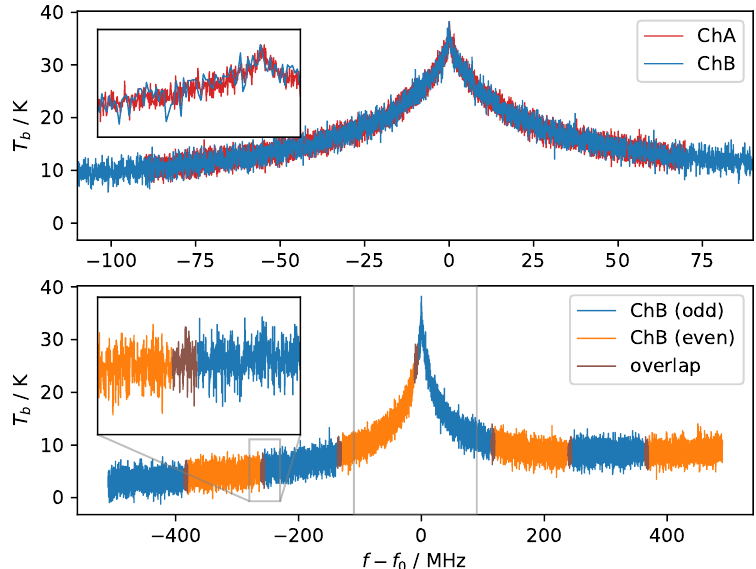
Figure 2. Spectra from the WIRA-C ChA (narrow) and WIRA-C ChB (wide) at an elevation angle of 40 ◦ . The bottom panel shows the different parts of the spectrum that were measured independently with alternating colors (odd/even). Frequencies are relative to the emission line center of ozone at f 0 = 142.17504 GHz.